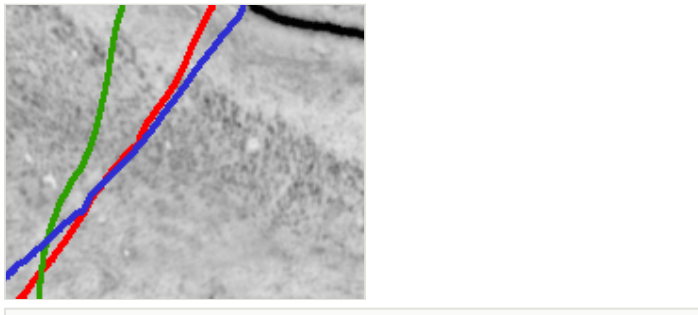
Figure 5. Example boundary estimates in the BigBrain